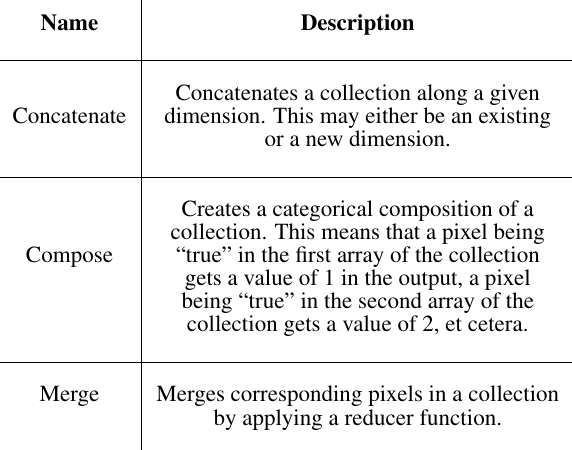
Table 2. Verbs for collections of semantic arrays.